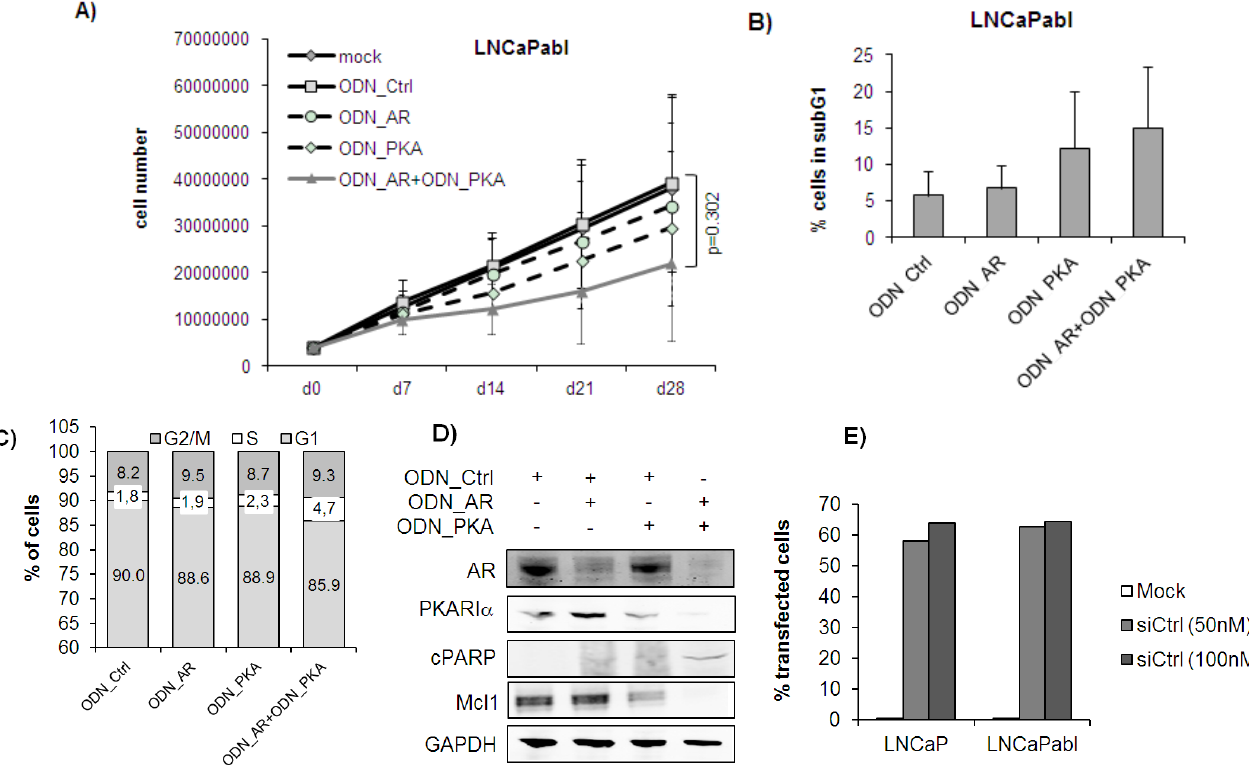
compared to the control. Serum PSA levels were also reduced by treatment with ODNs, although there were no significant differences measured between single and dual targeting (Figure 3B, p > 0.05, unpaired t -test). In particular, ODN_AR reduced serum PSA levels to 121.4 ± 153.5 ng/mL ( n = 5, range: 361.4–0.39 ng/mL), ODN_PKA to 92.2 ± 107.4 ng/mL ( n = 5, range: 224.8–0.16 ng/mL) and combined treatment to 112.7 ± 97.9 ng/mL ( n = 6, range: 269.8–1.5 ng/mL) compared to 405.7 ± 345.7 ng/mL ( n = 5, range: 998.9–105.3 ng/mL) in the ODN_Ctrl group. Figure 2. Single and dual targeting of AR and PKARI α in LNCaPabl in vitro . The treatment protocol described for LNCaP cells in the legend to Figure 1 was applied to LNCaPabl. ( A ) Cell number was counted weekly with a Casy cell counter after harvesting the cells with trypsin and displayed cumulatively; ( B ) The percentage of LNCaP cells in the subG1 phase was quantified by Nicoletti staining and subsequent flow cytometric measurement at the end of treatment (day 28); ( C ) Cell cycle distribution was measured after treatment of cells over four weeks. Cells were stained with propidium iodide and analyzed by flow cytometry. Graph shows mean percentages of cells in G1, S and G2M phases out of three separate experiments; ( D ) Expression of AR, PKARI α , cPARP and Mcl-1 was determined by Western blotting and normalized to expression levels of glyceraldehyde 3-phosphate dehydrogenase (GAPDH) after four weeks of treatment. Representative images were taken out of two independent experiments; ( E ) Transfection efficiency was measured by flow cytometry after transfection of cells with a fluorescently-labeled single-stranded control RNA-ODN (siCtrl) over 24